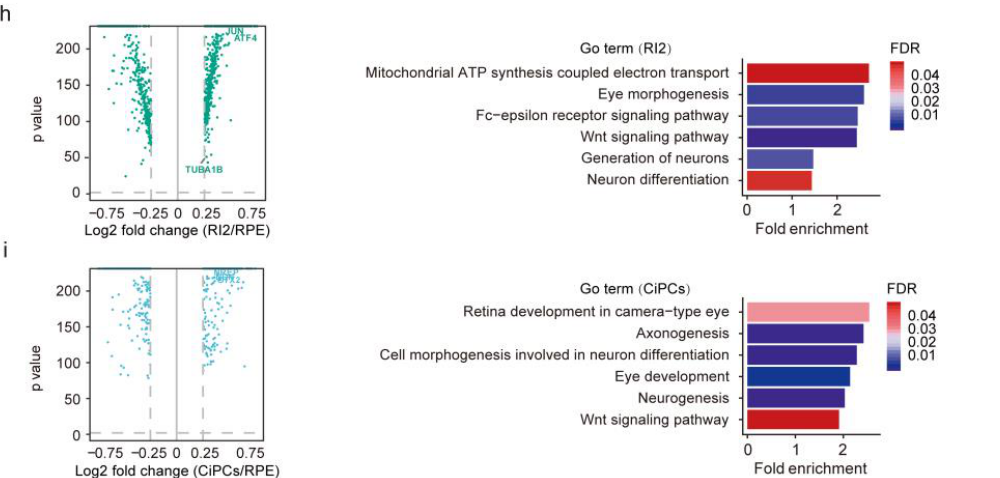
Figure 5. Single-cell analysis elicits homogeneous groups of cells during induction. ( a , b ) Uniform manifold approximation and projection (UMAP) analysis of single-cell transcriptomes from 23,661 cells annotated by treatment condition ( a ) and cell type ( b ), showing five cell clusters based on gene expression (each point represents a single cell). RPCs, retinal progenitor cells. ( c ) Dot plot showing marker genes identified in each cell subtype. ( d ) Bar plot showing the proportion of each cell subtype in different treatment conditions. ( e ) Bar plot showing the cell proportion of rod and cone photoreceptors inferred from scRNA-seq datasets. The proportion was determined by the percentage of cells with a positive rod score or cone score. ( f ) Bar plot showing the proportion of cell-cycle phases in each cell subtype. ( g ) Identification of the DEGs in RI1 compared with RPE (left) and the corresponding GO analysis (right). ( h ) Identification of the DEGs in RI2 compared with RPE (left) and the corresponding GO analysis (right). ( i ) Identification of the DEGs in CiPCs compared with RPE (left) and the corresponding GO analysis (right).